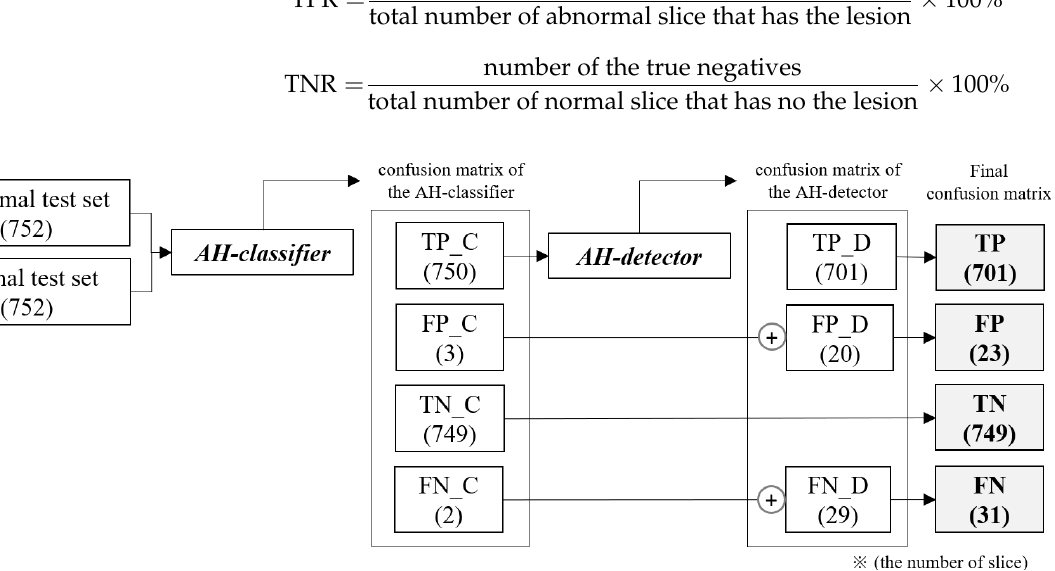
Figure 8. Confusion matrix generated for each step of the AI model for detecting AH lesions using the dataset.